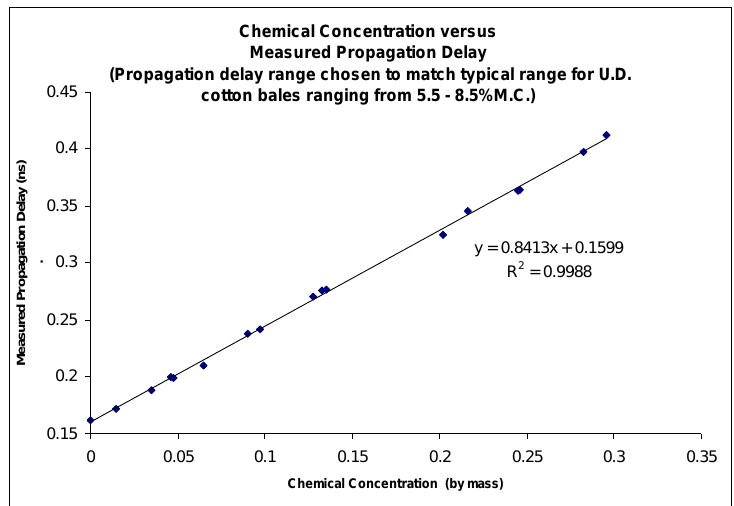
Figure 1. Sensor’s performance tested against known dielectric permittivity standards to determine accuracy of antennas for free space permittivity sensing. Chemical Concentration versus Measured Propagation Delay (Propagation delay range chosen to match typical range for U.D. cotton bales ranging from 5.5 - 8.5%M.C.)